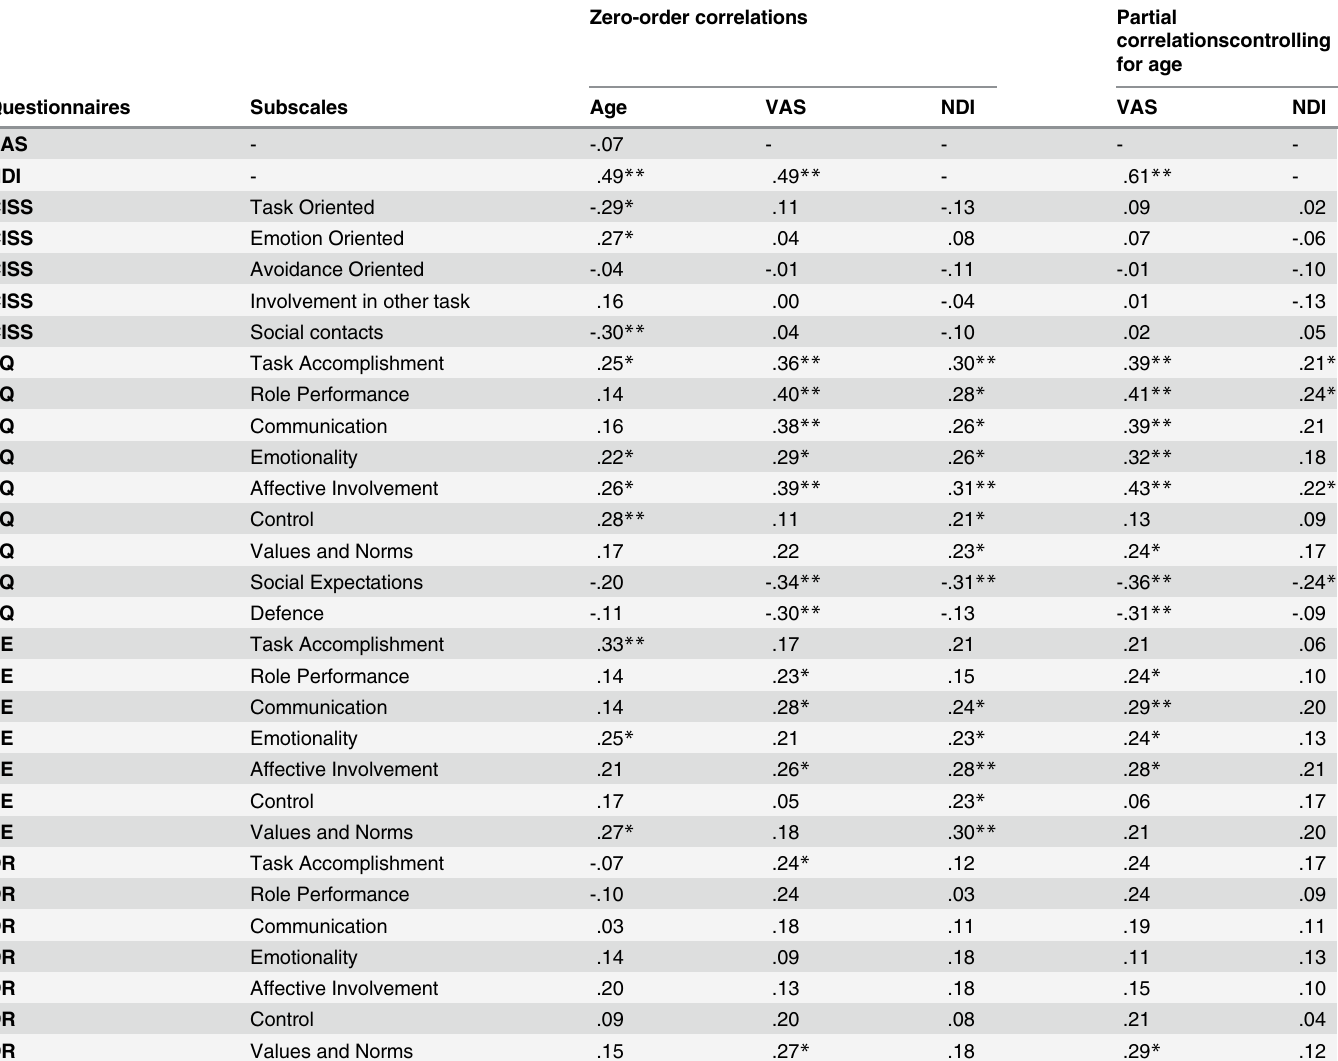
Table 1. Zero-order and partial correlations among the VAS, NDI and age, and family functioning and coping strategies. Zero-order